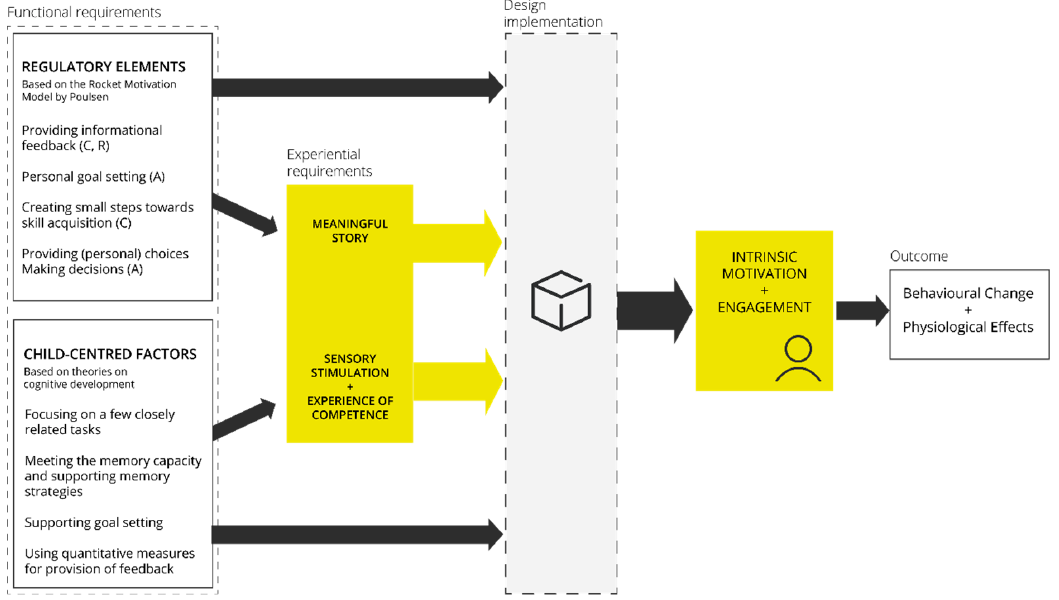
Figure 2. The Design for Child Engagement (DCE) Framework. Functional and experiential